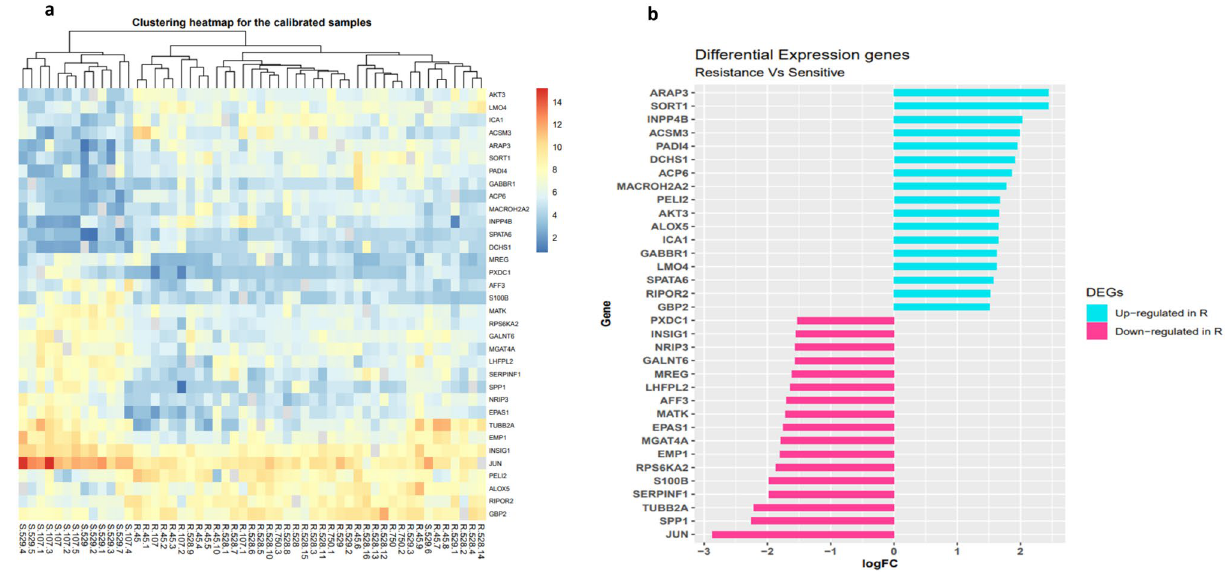
Figure 5. Heatmap and bar plot of Log fold changes of the most significantly DEGs. ( a ) The heatmap indicates the normalized relative expression value of the 34 most significantly differentially expressed genes (DEGs) between AML chemo-resistance and AML chemo-sensitive samples. Each column represents AML samples and all samples were divided to two clusters based on their characteristic (chemo-resistant and chemo-sensitive) by a hierarchical clustering analysis. Hierarchical clustering for the scaled gene expression matrix was based on the Euclidean correlation. The gradual color from orange to blue represents the expression changes from upregulated to downregulated genes. ( b ) The plot shows fold change of differential expression genes including 17 downregulated (pink) and 17 upregulated (blue) statuses in resistance group in compared to sensitive group. The Figure was created using the ggplot2 package version 3.3.3 in R 74